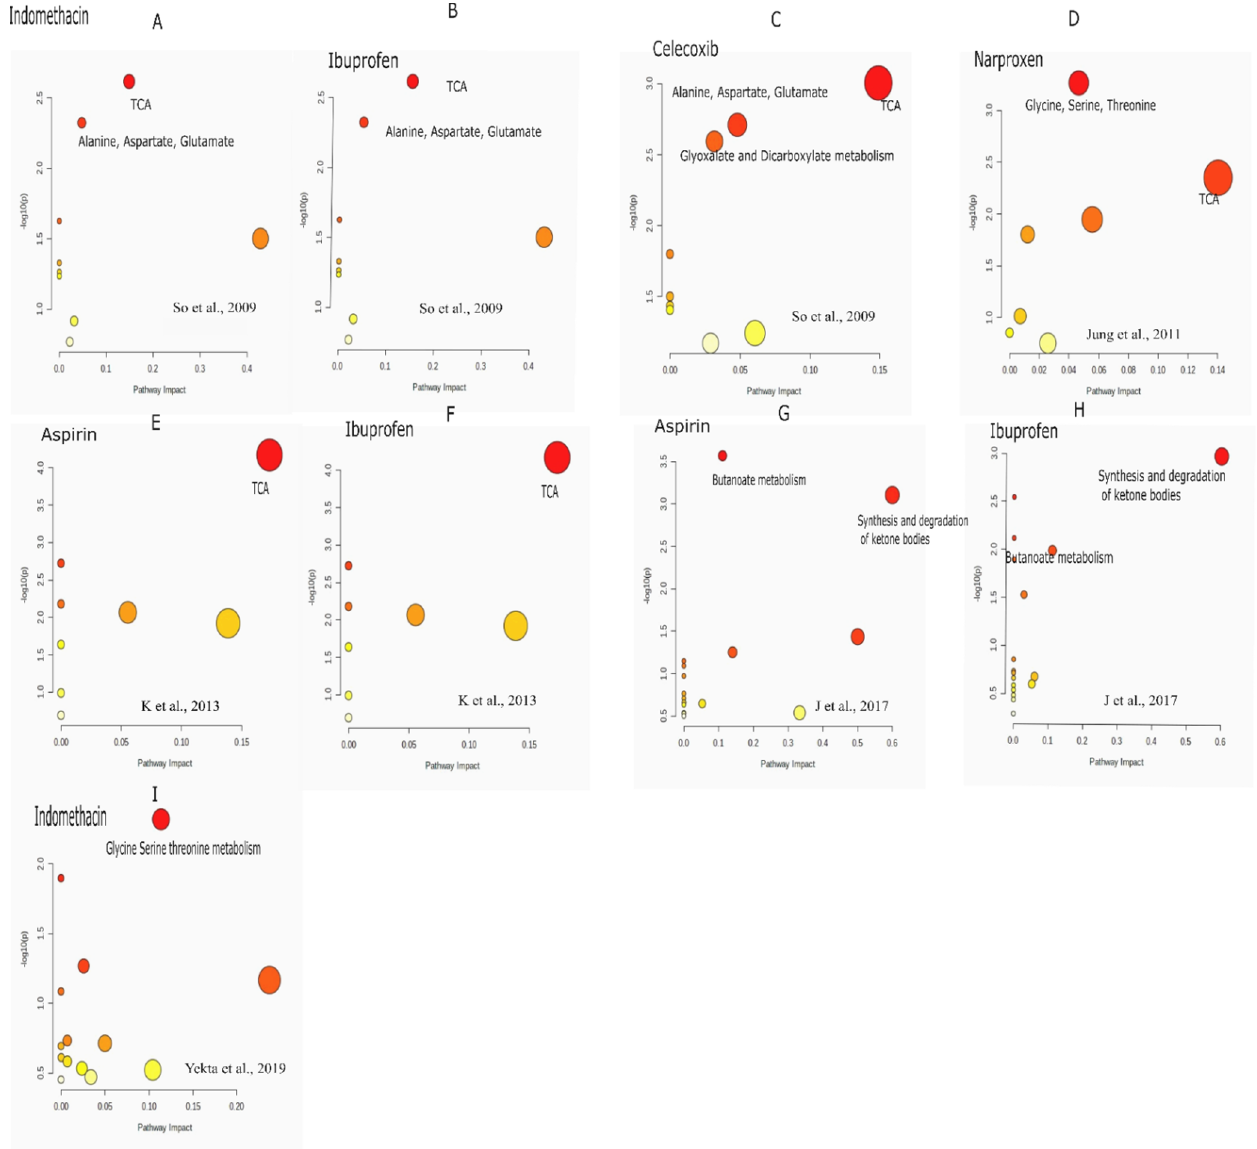
Figure 1. Pathway analysis performed on the published literature. ( A – C ) are pathway analysis done from the literature, So et al.,2009; ( D ) Jung et al.,2011; ( E – F ) K et al. 2013; ( G – H ) J et al. 2017. ( I ) Yekta et al. 2019.